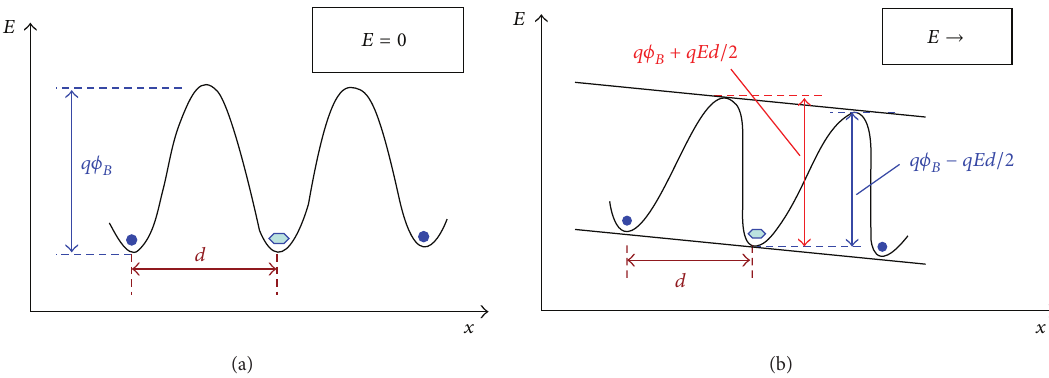
Figure 28: Energy band diagram of ionic conduction (a) without the applied electric field and (b) with the applied electric field. 𝐸 is the applied electric field, 𝑑 is the spacing between ionic sites, and 𝑞𝜙 𝐵 is the potential barrier height.